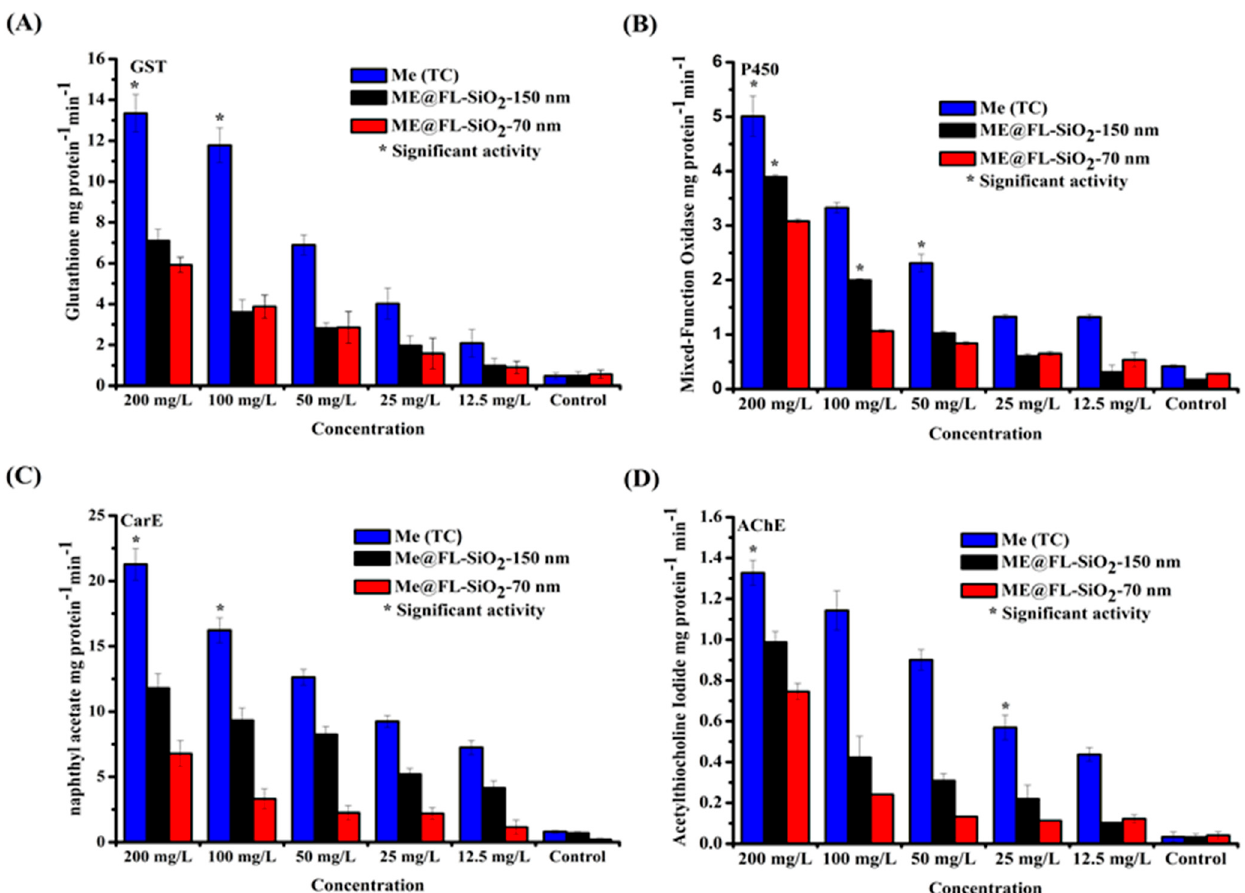
Figure 5. Detoxification enzyme activities in P. xylostella larvae treated with Me (TC) and Me@FLSiO 2 NPs under different concentrations ( A – D ). * represents the significant values.